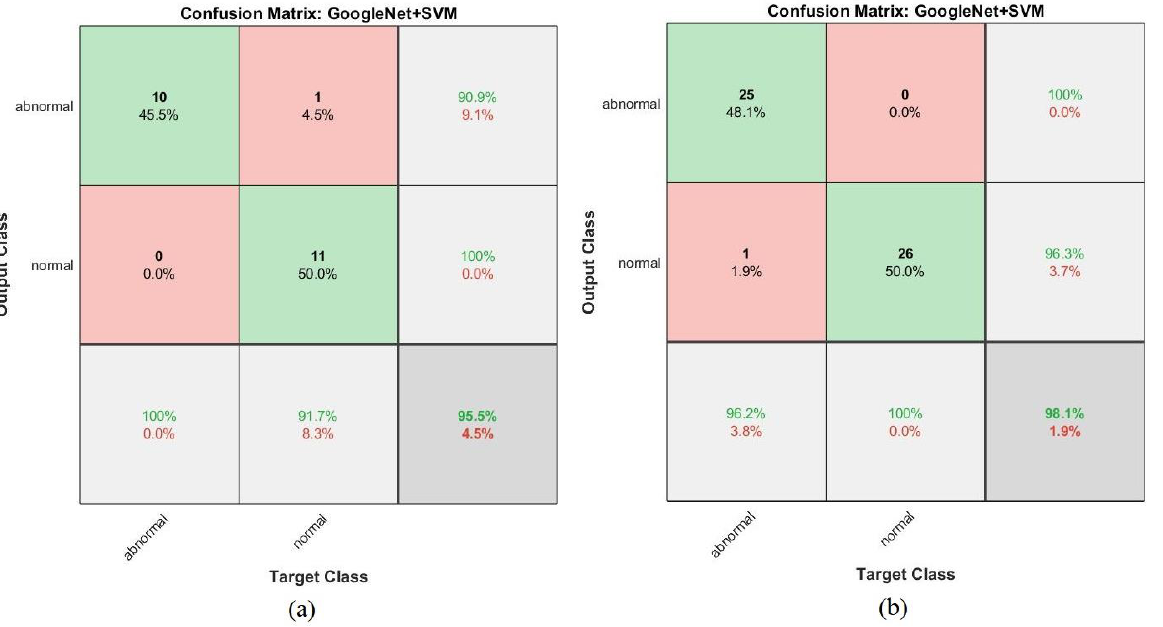
Figure 27. Confusion matrix for the GoogLeNet + SVM hybrid technique for the ( a ) ALL_IDB1 and ( b ) ALL_IDB2 datasets.